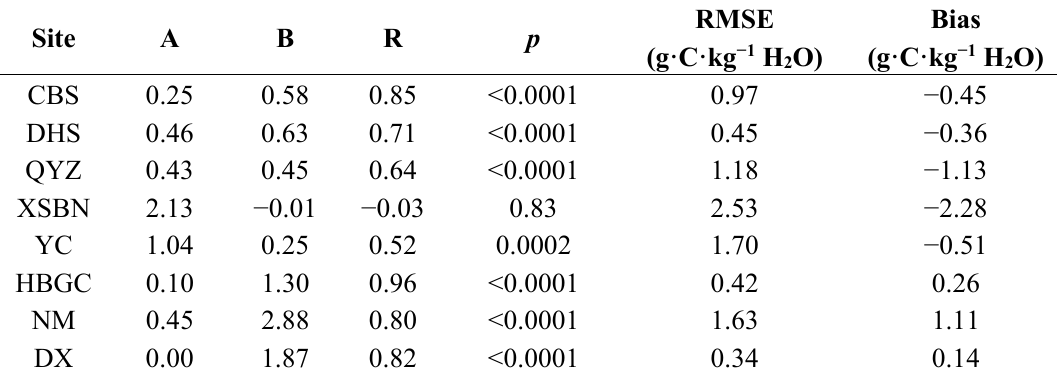
Figure 1. Comparison of MODIS- and eddy covariance-derived eight-day Water Use Efficiency (WUE) at eight sites of the Chinese Flux Observation and Research Network (ChinaFLUX). ( a ) CBS; ( b ) DHS; ( c ) QYZ; ( d ) XSBN; ( e ) YC; ( f ) HBGC; ( g ) NM; ( h ) DX. Table 3. Relationships (y = A + B × X) of eight-day WUE between MODIS (y) and eddy covariance observation (x) with correlation coefficient (R), significance (p), root mean square error (RMSE) and